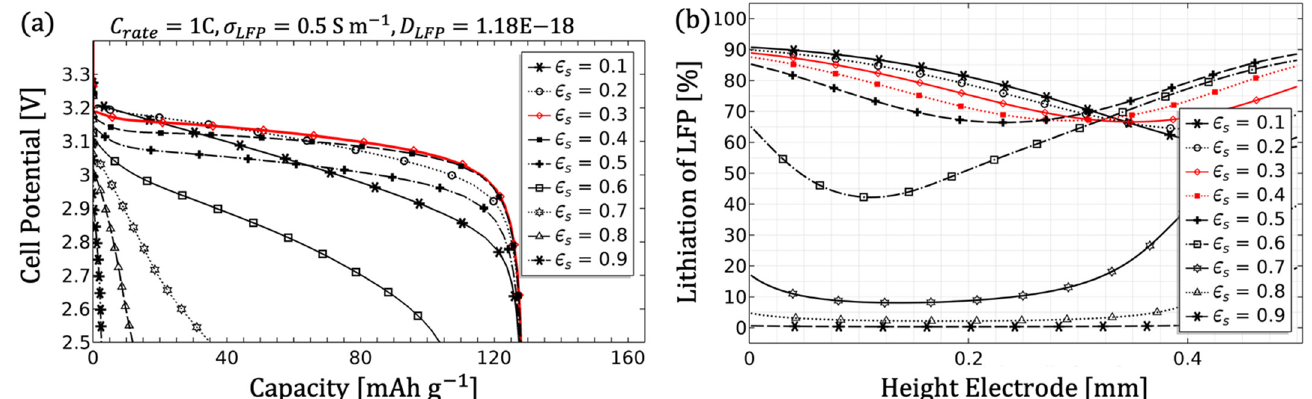
Figure 3. Parameter variation of the solid volume fraction. The discharge performance at 1C is shown in ( a ), and the lithiation along the electrode at a DoD = 1 is illustrated in ( b ), where the height of 0 mm corresponds to a position close to the current collector, and 0.5 mm is situated near the electrolyte reservoir.